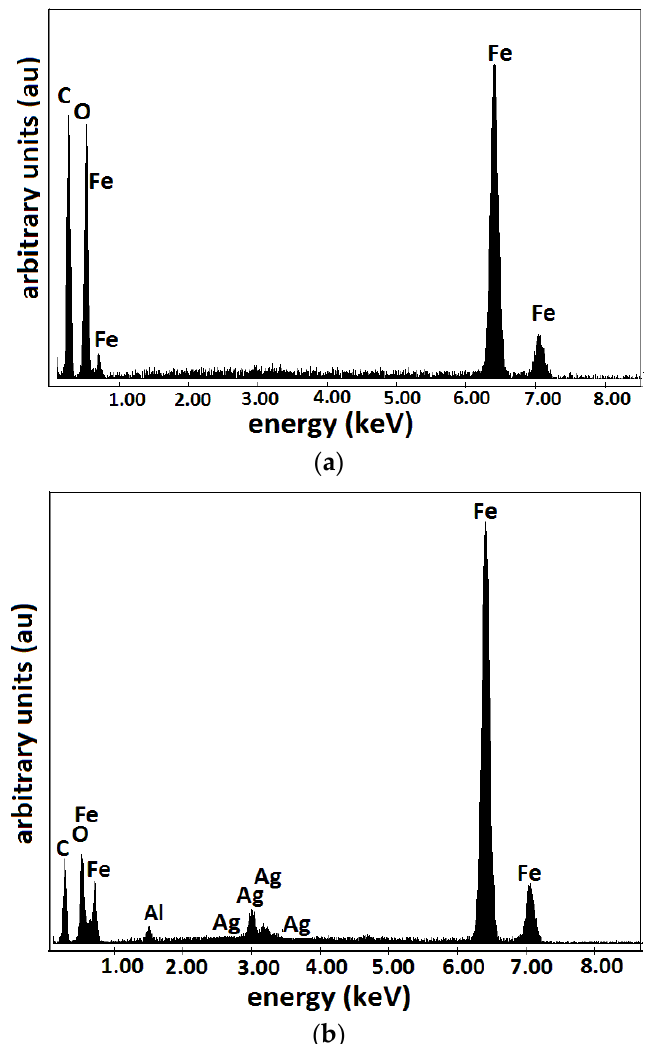
Figure 5. EDX elemental analysis of Ms microfibers containing: ( a ) CI; ( b ) CI and silver microparti- cles.